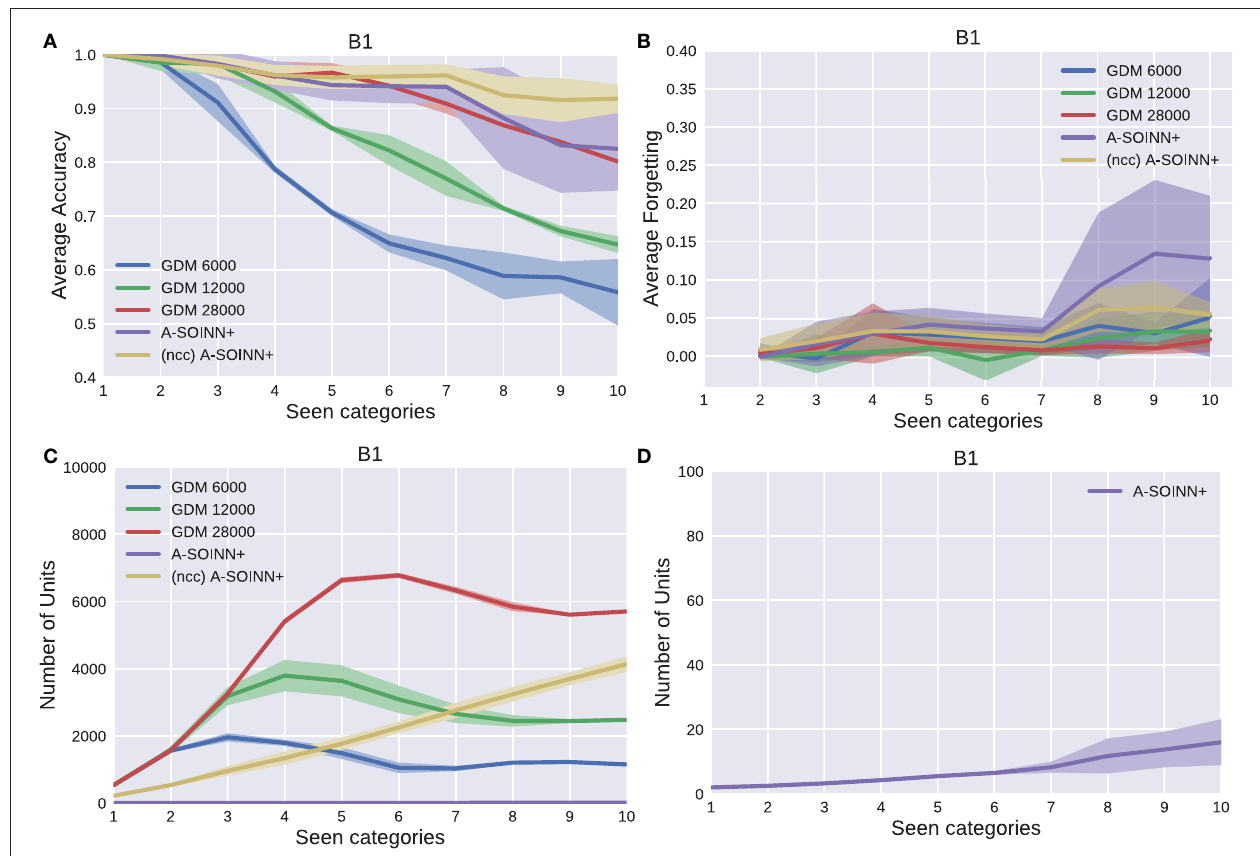
FIGURE 5 | The results of the first experiment. GDM 6,000, GDM 12,000, GDM 28,000, A-SOINN+, and A-SOINN+ without node creation constraint are represented by blue, green, red, purple, and yellow lines. The x-axes represent the number of learned tasks and, therefore, the number of seen categories over time from 1 to 10. (A) is showing the average accuracy of each model on the y-axis in the interval 0.4 to 1.0. (B) is presenting the average forgetting in the interval − 0.04 to 0.4, (C) the number of units in the interval 0 to 10,000, and (D) the number of units focused on the A-SOINN+ model in the interval zero to 100. All results are averaged across the four repetitions. The shaded areas represent the resulting standard deviation